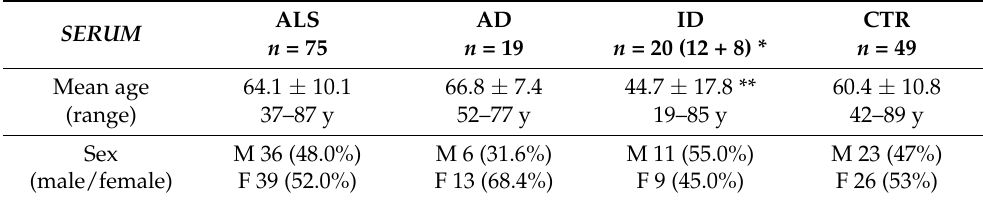
Table 1. Characterization of patients/controls participating in the